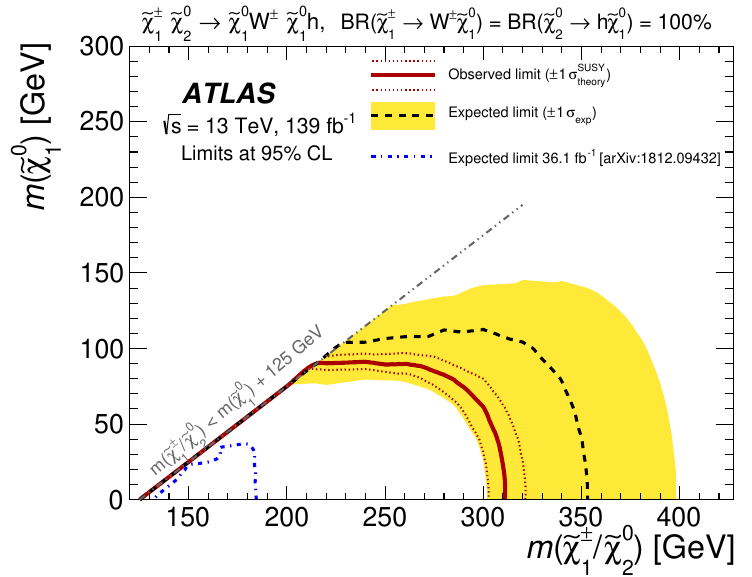
Figure 10 . The observed (solid line) and expected (dashed lines) exclusion limit contours at 95% CL for the ~ (cid:31) (cid:6) ~ (cid:31) 0 production in the m (~ (cid:31) (cid:6) = ~ (cid:31) 0 ){ m (~ (cid:31) 0 ) plane. The dotted lines represent the (cid:6) 1 (cid:27) 1 2 1 2 1 theoretical uncertainty for the observed limit. The (cid:6) 1 (cid:27) expected exclusion limit contour is shown as the shaded band. The expected limit for the 36.1 fb (cid:0) 1 analysis [32] is also shown for comparison in the dash-dotted